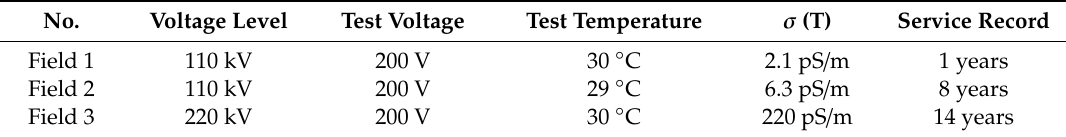
Table 9. Details of field